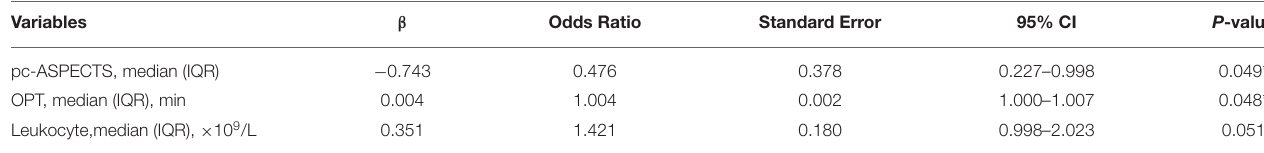
TABLE 2 | Independent risk factors for poor outcome at 90